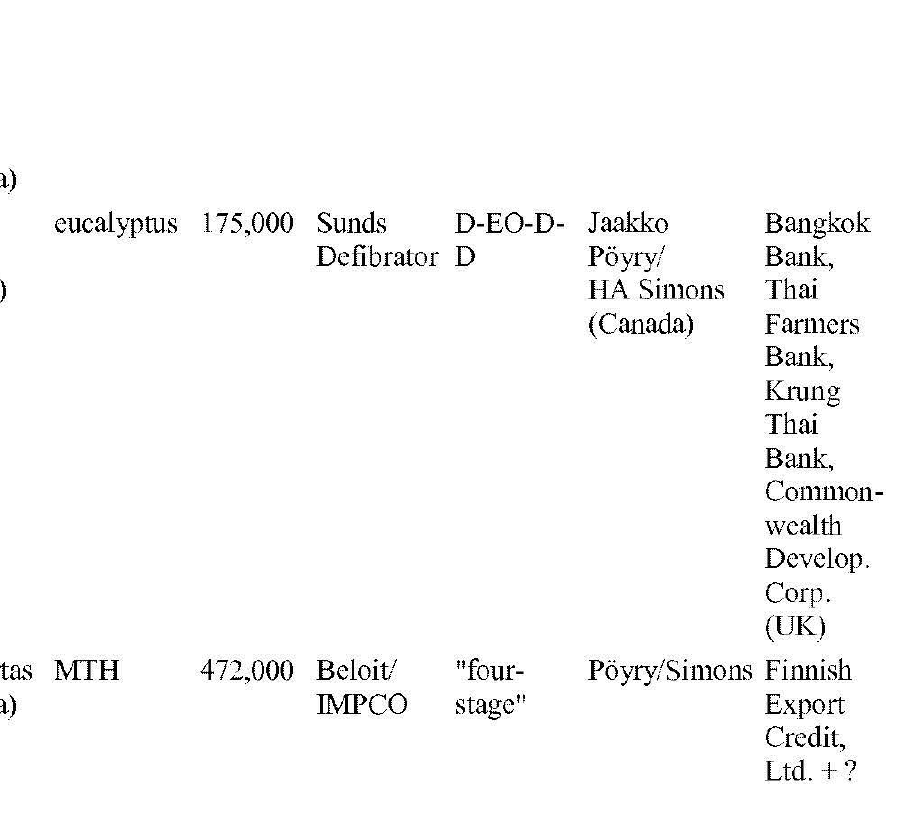
Table 1. Technology employed in bleached chemical pulp production in Indonesia, Malaysia, and Thailand, 1981-97 ( various sources).